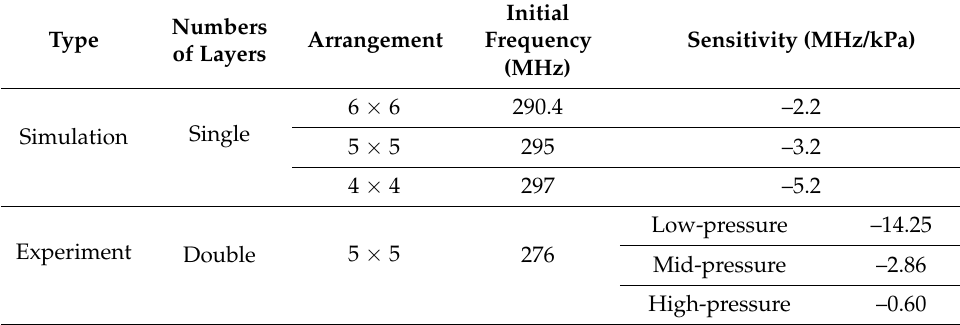
Table A3. Comparison of